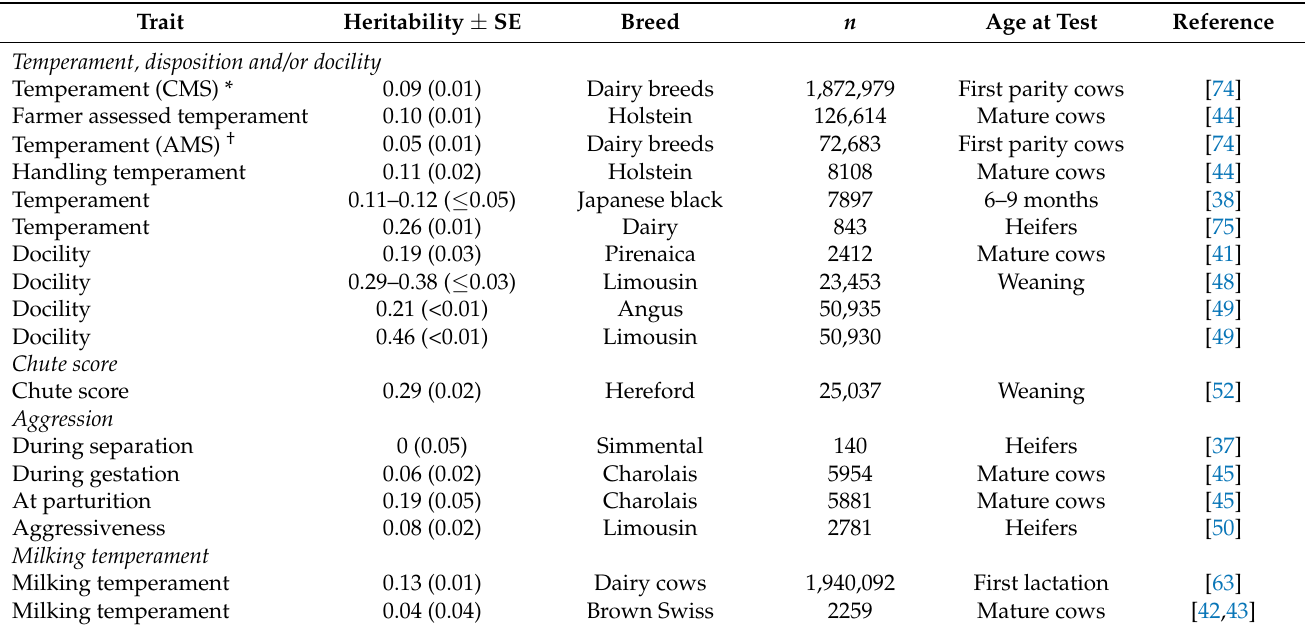
Table 2. Behavioural traits (grouped by trait category in italics) which were considered to have reported high accuracy heritabilities (SE ≤